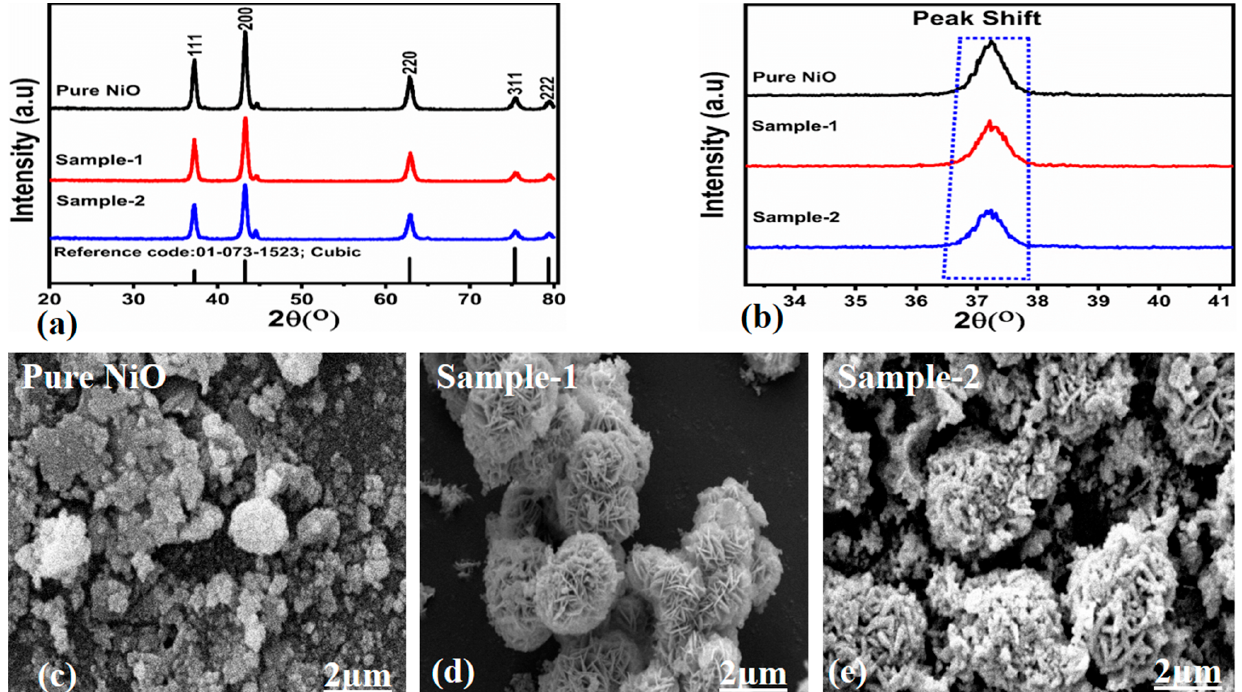
Figure 1. ( a ) X-rays fiffraction patterns of NiO nanostructures prepared with 10 mL, 15 mL, and without the bitter gourd peel extract, ( b ) the shift in the two-theta angle, ( c ) SEM image of pure NiO, ( d ) SEM image of NiO nanostructures prepared with 10 mL of bitter gourd peel extract, ( e ) SEM image of NiO nanostructures with 15 mL of bitter gourd peel extract.